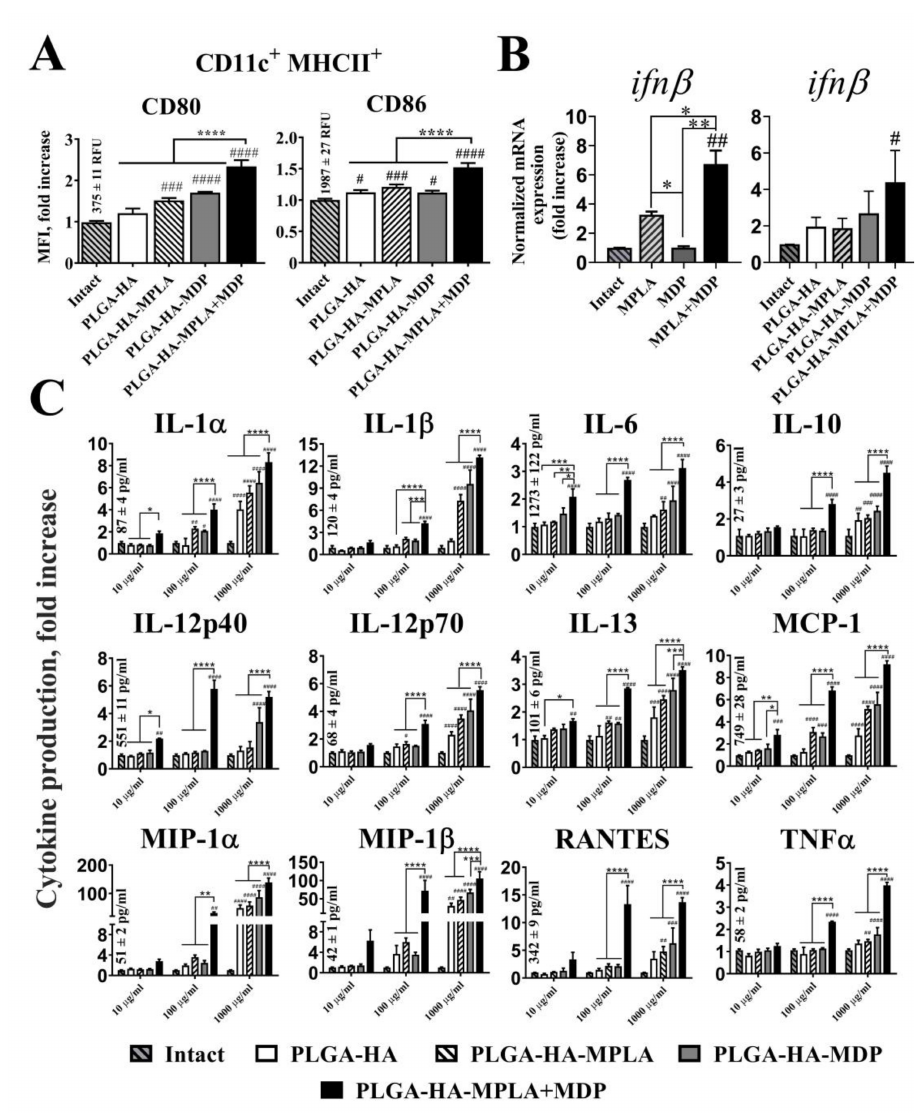
Figure 4. PLGA NPs containing both MPLA and MDP significantly enhance the cytokine response of BMDCs as well as the expression of maturation markers compared to NPs containing individual PRR agonists. ( A ) The expression of the maturation markers, CD80 and CD86, of BMDCs treated with PLGA NPs. MFI (indicating expression level) fold increase values relative to intact (untreated) cells ± SD are shown. Mean values (indicated above the bars) of intact cells were taken equal to 1 (100%). Experiment was performed in triplicate and repeated twice. ( B ) qRT-PCR analysis of ifn β expression in BMDCs following stimulation with soluble MPLA (1 µ g / mL) and MDP (20 µ g / mL) molecules as well as PLGA NPs (100 µ g / mL) for 72 h. The data were normalized to gapdh in each sample and presented as mean fold change ( ± SD) relative to intact cells (taken as 1). Minimum three replicates were used in each group. ( C ) Cytokine levels in cell-free culture supernatants from the BMDCs treated with PLGA NPs in indicated doses. Data represent the mean ( n = 5) fold increase over intact cells ± SD. Mean values (mean concentrations ± SD are indicated above the bars) in intact cells were taken equal to 1 (100%). Significant di ff erences between PLGA NPs and intact cells are indicated by hashes: # for p < 0.05, ## for p < 0.01, ### for p < 0.001, or #### for p < 0.0001. Significant di ff erences between PLGA-HA-MPLA + MDP and PLGA-HA-MPLA or PLGA-HA-MDP are indicated by asterisks and brackets: * for p < 0.05, ** for p < 0.01, *** for p < 0.001, or **** for p < 0.0001. p -values were calculated using one-way ANOVA post-hoc Tukey’s test ( A,B ) and two-way ANOVA with Dunnett’s post hoc test ( C